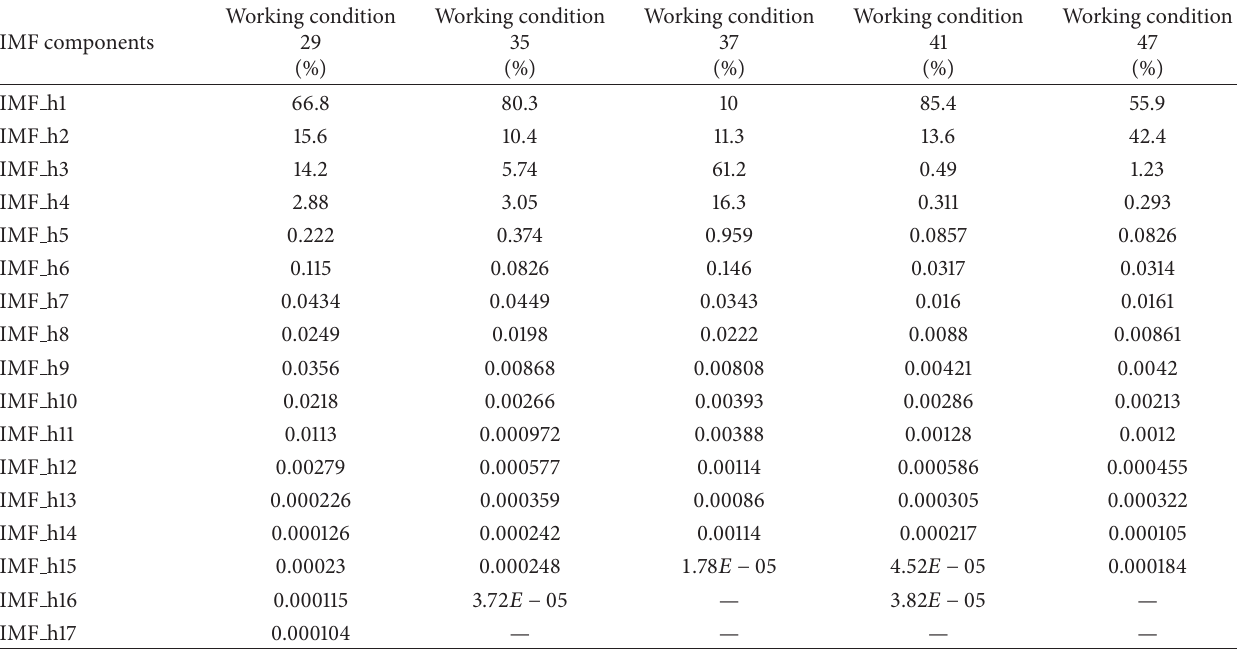
Figure 21: Destruction of the specimen side figure. Table 15: IMF component energy percentage for selected effective microseism signals by